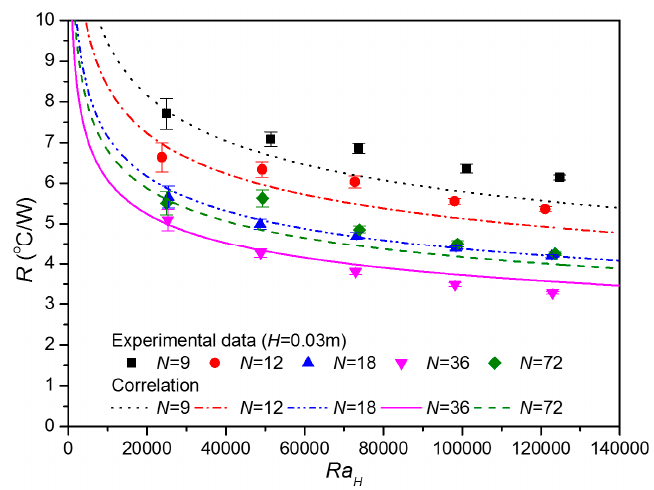
Figure 8. Effect of fin number on thermal resistance.